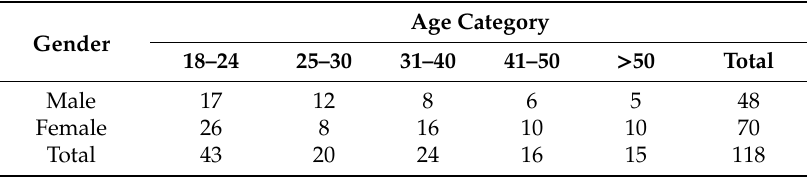
Table 3. Gender and age group composition of the consumer sensory